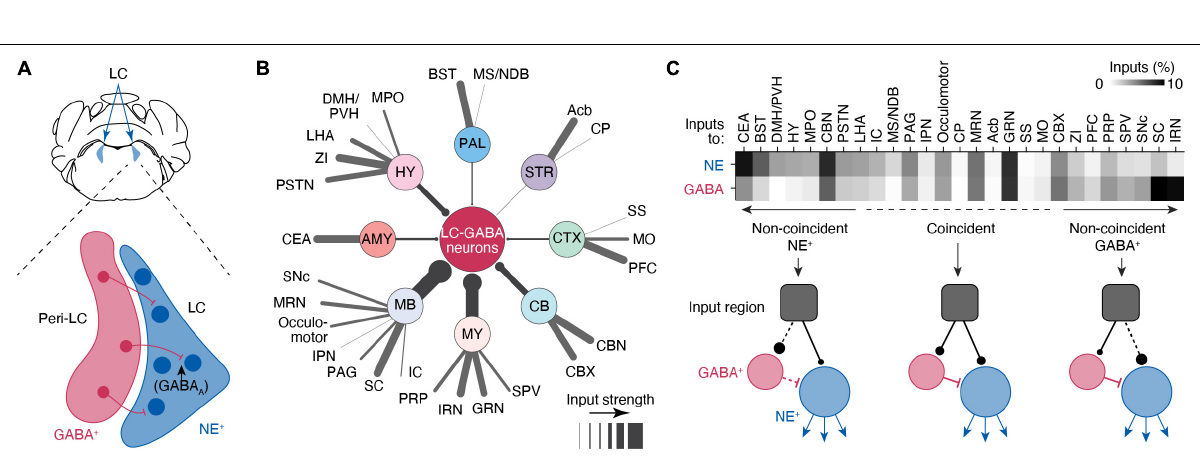
FIGURE 2 | Circuits controlling local inhibition of LC-NE+ neurons. (A) Illustration of a coronal view of the LC and medial pericoeruleus area showing the location of LC-GABA and -NE neurons. (B) Distal inputs to LC-GABA neurons obtained by retrograde tracing using rabies virus targeted at LC-NE neurons. Input regions are grouped by: cortex (CTX), striatum (STR), pallidum (PAL), hypothalamus (HY), amygdala (AMY), midbrain (MB), medulla (MY), and cerebellum (CV). The thickness of each line represents the strength of the input from each region. Input strength was calculated by counting the number of cells retrogradely labeled in a specific area and dividing it by the total number of retrogradely labeled neurons. Regions providing less than 0.5% of inputs were left out of this diagram. Local inputs from the pons were also excluded. (C) Comparison between the input strength to LC-NE versus LC-GABA for all distal brain regions targeting the LC area. The darkness of each square in the top graph represents the fraction of input each region contributes to total input. Regions are divided between three types depending on whether they send coincident or non-coincident inputs to LC-NE or LC-GABA neurons. See Figure 1 for a list of abbreviations. Data in (B,C) from Breton-Provencher and Sur